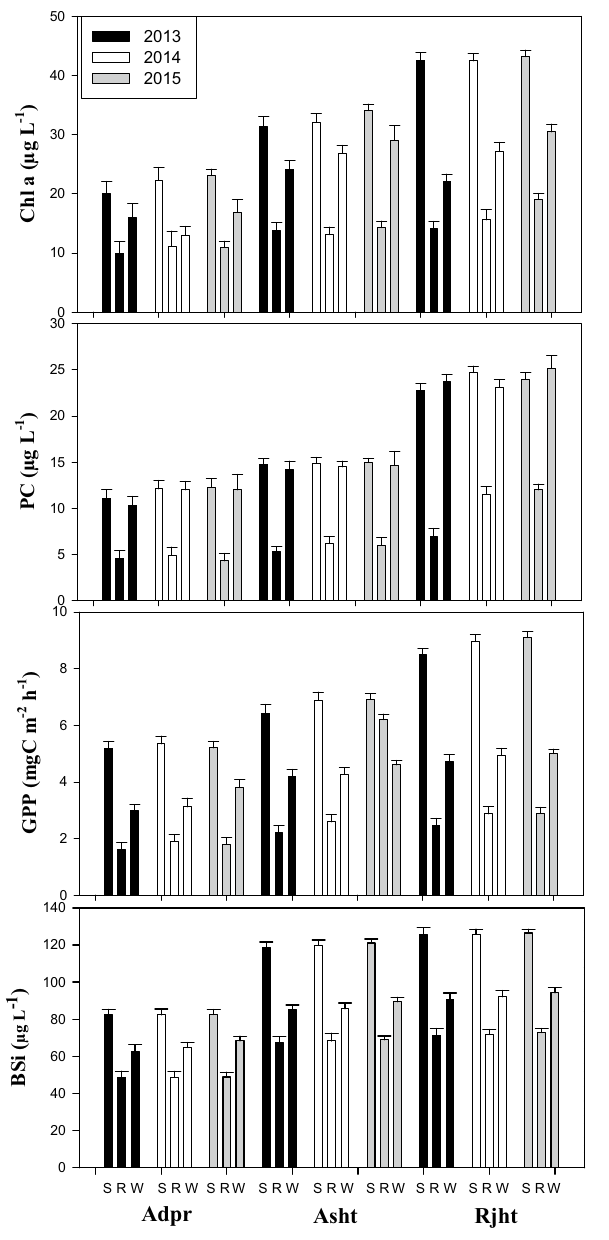
Fig. 4 Trends in productivity variables at study sites. Values are mean ( n = 27, for BSi n = 9) ± SD. Chl a chlorophyll a , PC phycocyanin, GPP gross primary productivity, BSi biogenic silica, S summer, R rainy season, W winter